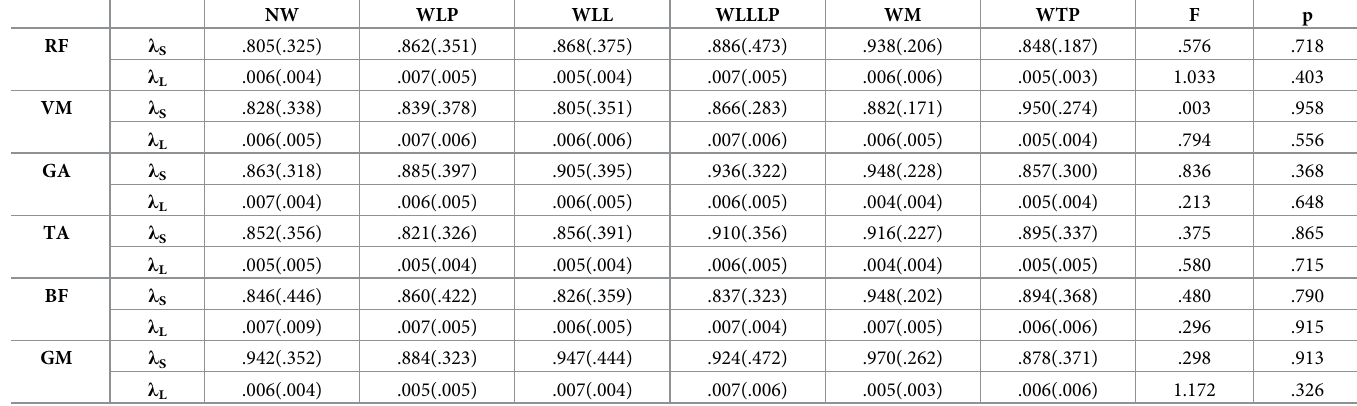
Table 2. Descriptive measures of λ S and λ L for the RF, VM, GA, TA, BF, and GM and their differences in various walking conditions in sagittal, frontal and horizon- tal